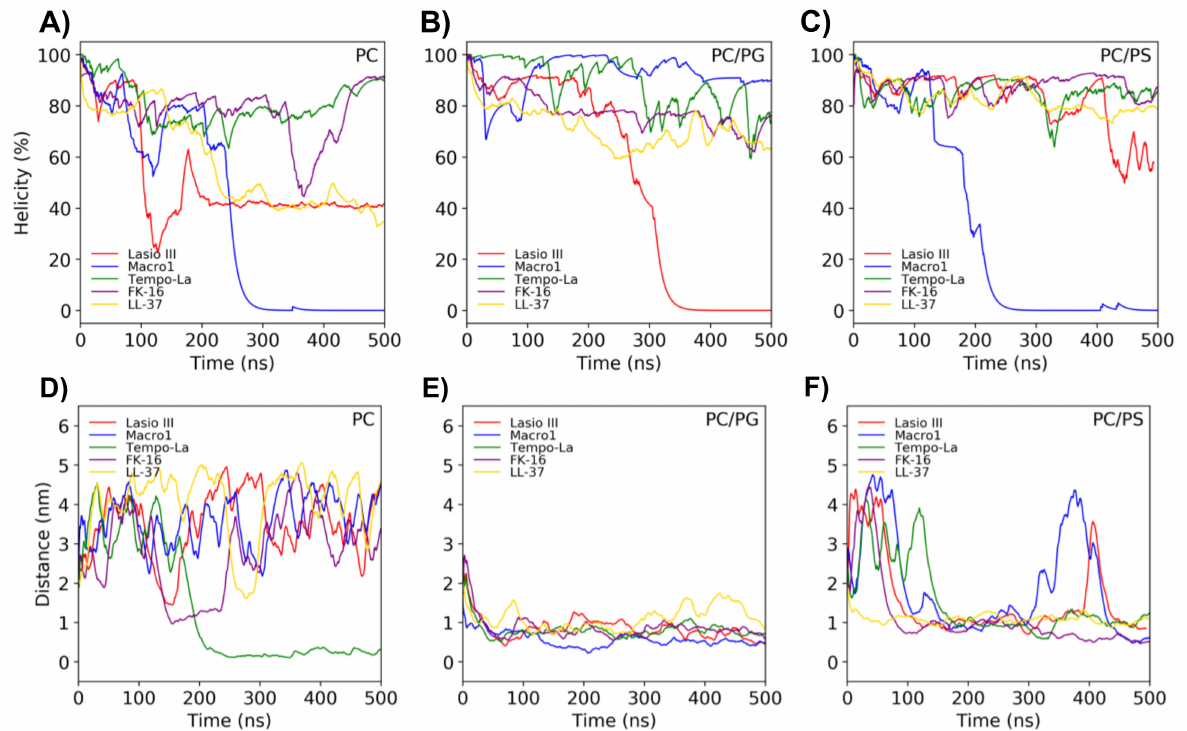
Figure 5. Peptide helicity changes in the presence of model membranes and distance of the ACPs from the bilayer during the MD simulations. The helicity of the peptides in the presence of the model membranes ( A ) PC, ( B ) PC/PG and ( C ) PC/PS is defined as the number of the residues with α -helical structure divided by the total number of the residues minus the two terminal residues (for further information see the methods section). The distance of the peptides from the surface of the different model membranes ( D ) PC, ( E ) PC/PG and ( F ) PC/PS as a function of the simulation